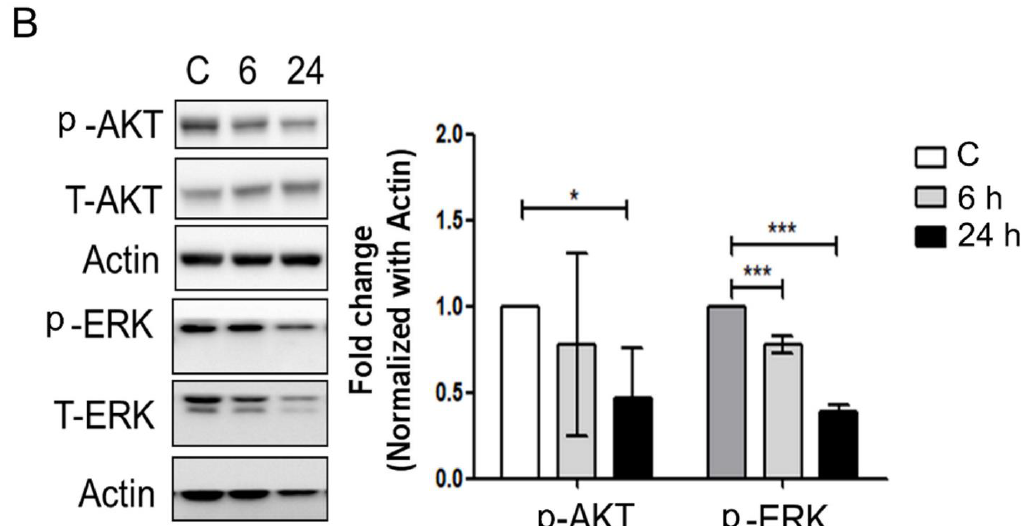
Figure 3. Mechanical injury through stretching upregulates p-Tau and p-GSK3β protein levels and decreases the insulin pathway. ( A ) p-Tau and p-GSK3β; ( B ) p-AKT and p-ERK; proteins expressions. p-GSK3β and p-Tau S396 protein levels significantly increased in the 25%, 1 Hz group at 6 and 24 h of stretching. However, the p-AKT and p-ERK protein expressions had the reverse effect. The values are presented means ± SEM (n = 6); *** p < 0.001; * p < 0.05. GSK3β, glycogen synthase kinase 3; ERK, extracellular-signal-regulated kinase.